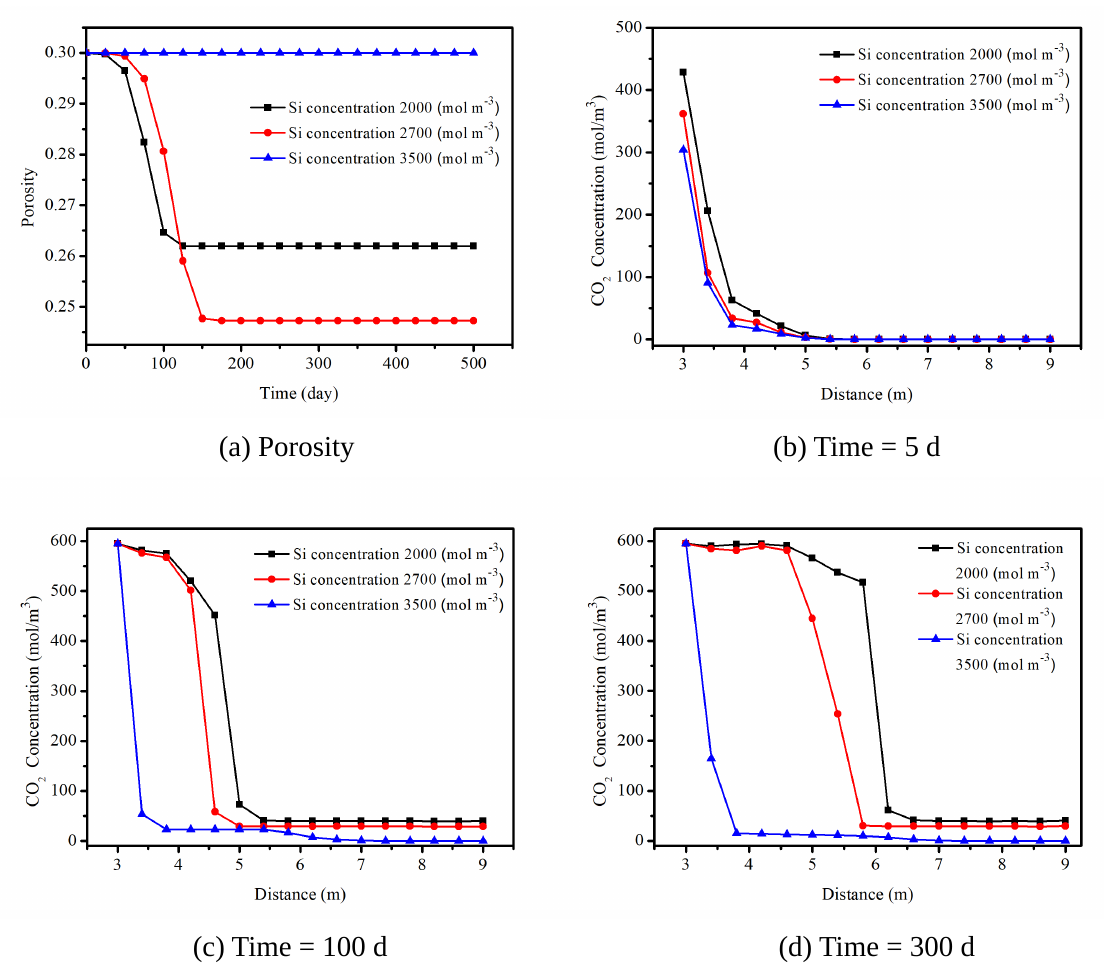
Figure 6. Influence of initial reactant concentration (Si) on CO 2 sequestration; ( a ) the variation of porosity with time; ( b )–( d ) the variation of CO 2 concentration with distance on five days, 100 days, and 300